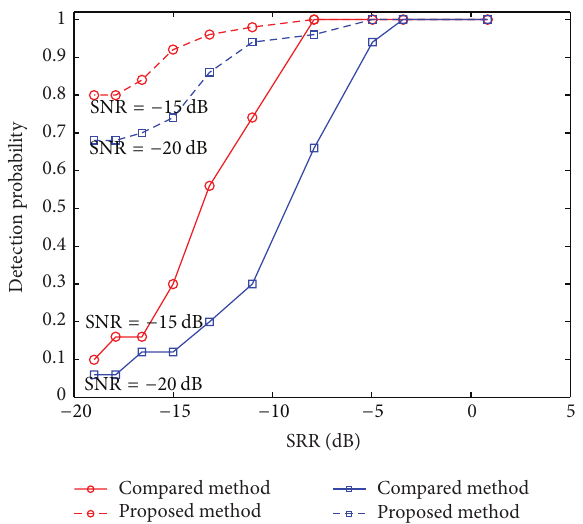
Figure 7: Detection probabilities with two detection methods over different SNR and SRR